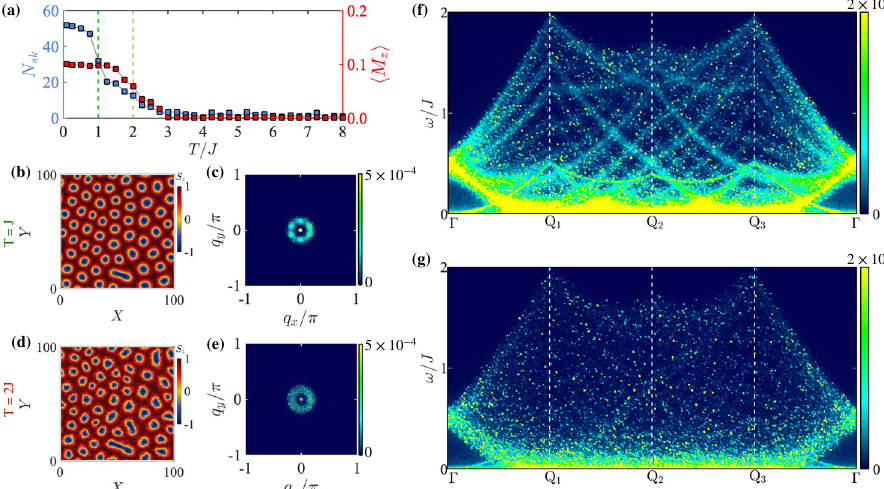
Fig. 3 Spin waves in the diffusive regime for skyrmion crystallization. a Temperature variation of the skyrmion number N sk and the average magnetization component 〈 M z 〉 , showing the gradual transition to the triangular SkX below T ⪅ 2.5 J . b , c The Spin con fi guration and the zero-energy contour of the dynamical spin structure factor S ( q , ω ) at temperature T = J and magnetic fi eld H z = 0.18 J . d , e The spin con fi guration and the zero-energy contour of S ( q , ω ) at temperature T = 2 J and magnetic fi eld H z = 0.18 J . f , g show the plots of S ( q , ω ) along the momentum path Γ − Q 1 − Q 2 − Q 3 − Γ at the two temperatures, representatives of the diffusive regime for the SkX